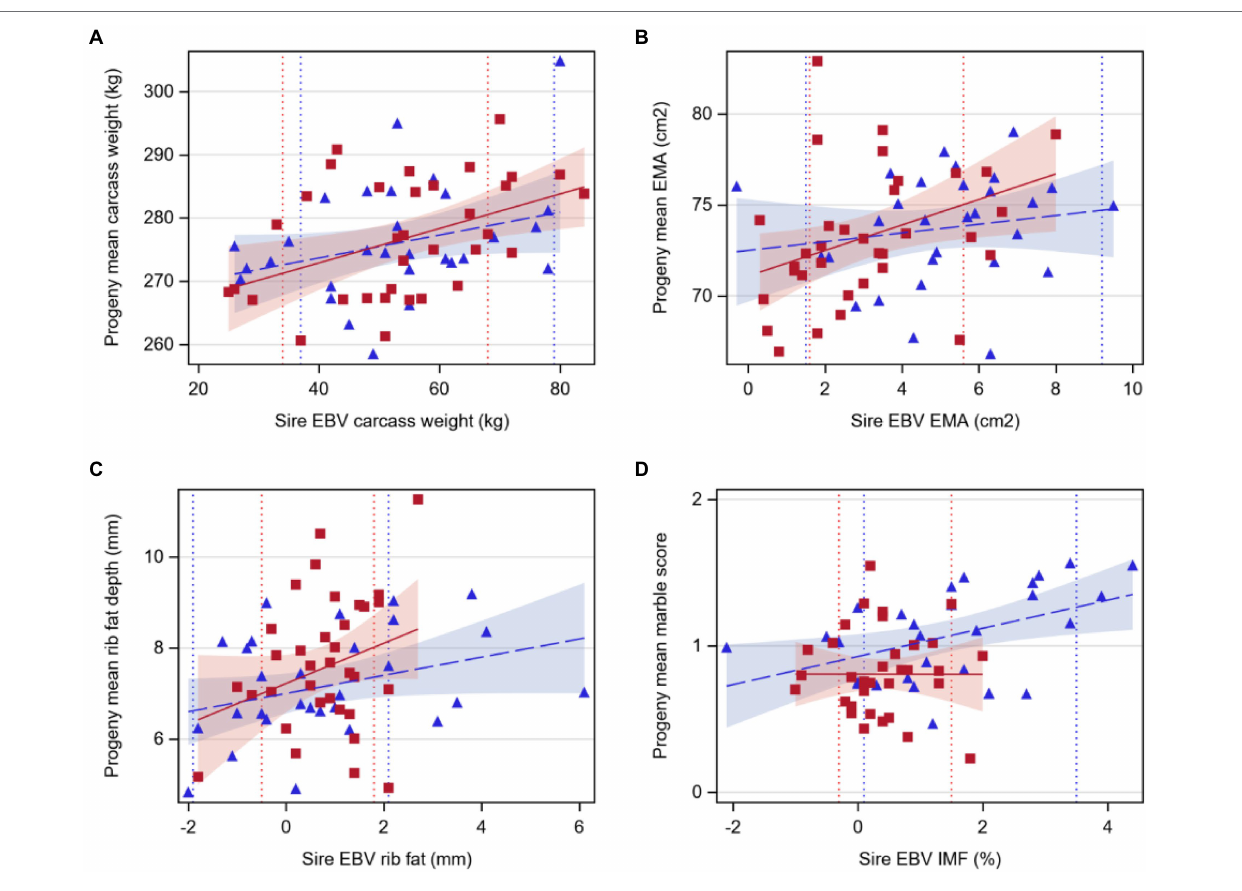
FIGURE 3 | Regression of least-squares means of beef-cross-dairy progeny groups on sire EBV for: (A) carcass weight (kg), ( B) eye muscle area (EMA, cm 2 ), (C) rib fat depth (mm), and (D) marble score (on intramuscular fat, IMF %). Individual sires are represented by one data point (Angus, blue triangles, n = 29; Hereford, red squares, n = 34), and the regression lines by breed are indicated by lines (Angus, dashed line; Hereford, solid line). Shaded areas indicate 95% confidence intervals for the expected regression line for each breed (Angus, blue; Hereford, red). Colored dotted lines indicate 5 and 95th EBV percentiles for 2018 born calves within the BREEDPLAN population for each breed (Angus, blue; Hereford, red). Details of regression coefficients are presented in Table 5